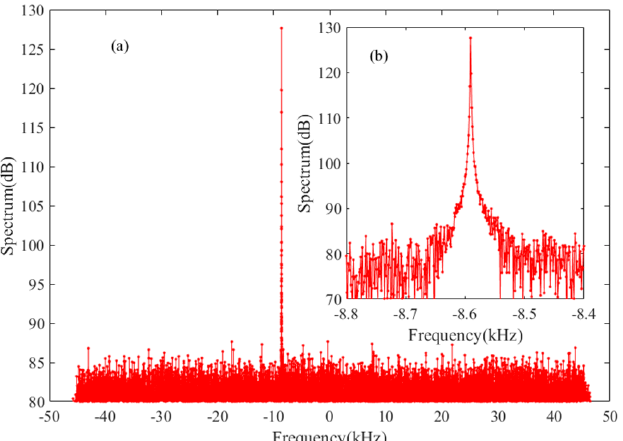
Figure 7. The spectrum of Tianwen-1 observed at the KS station on 26 February 2021, with sampling frequency of 100 kHz. ( a ) the whole spectrum; ( b ) the enlarged view of carrier zone.